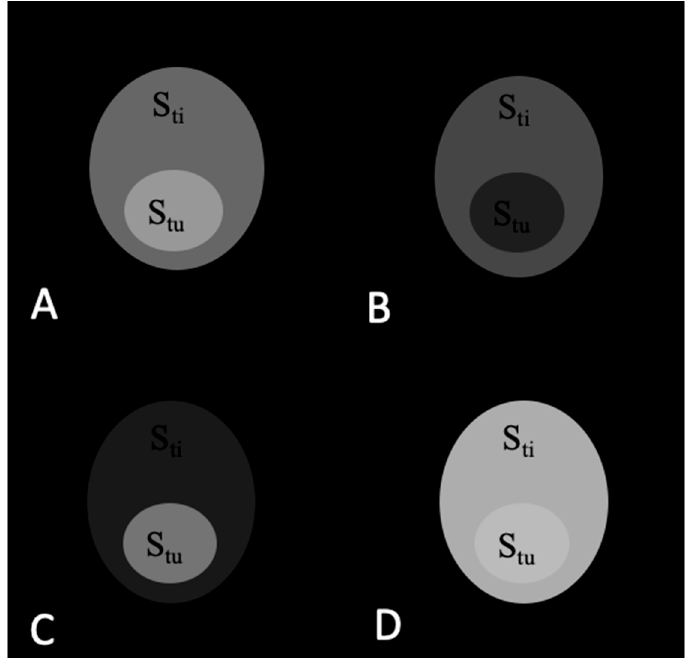
Figure 6. MR images of the tumor phantom model after injection of the T 1 /T 2 contrast agent: ( A ) T 1 w. ( B ) T 2 w. ( C ) Subtracted T 1 w- T 2 w. ( D ) Added T 1 w+ T 2 w. The highest TC value is 3.83 in image ( C ).